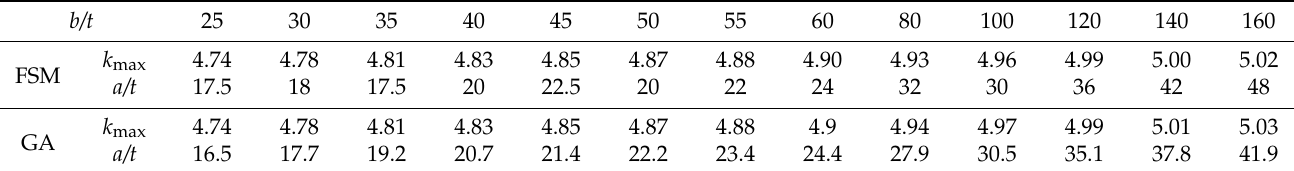
Table 6. Values of a/t and k max based on the FSM and GA.